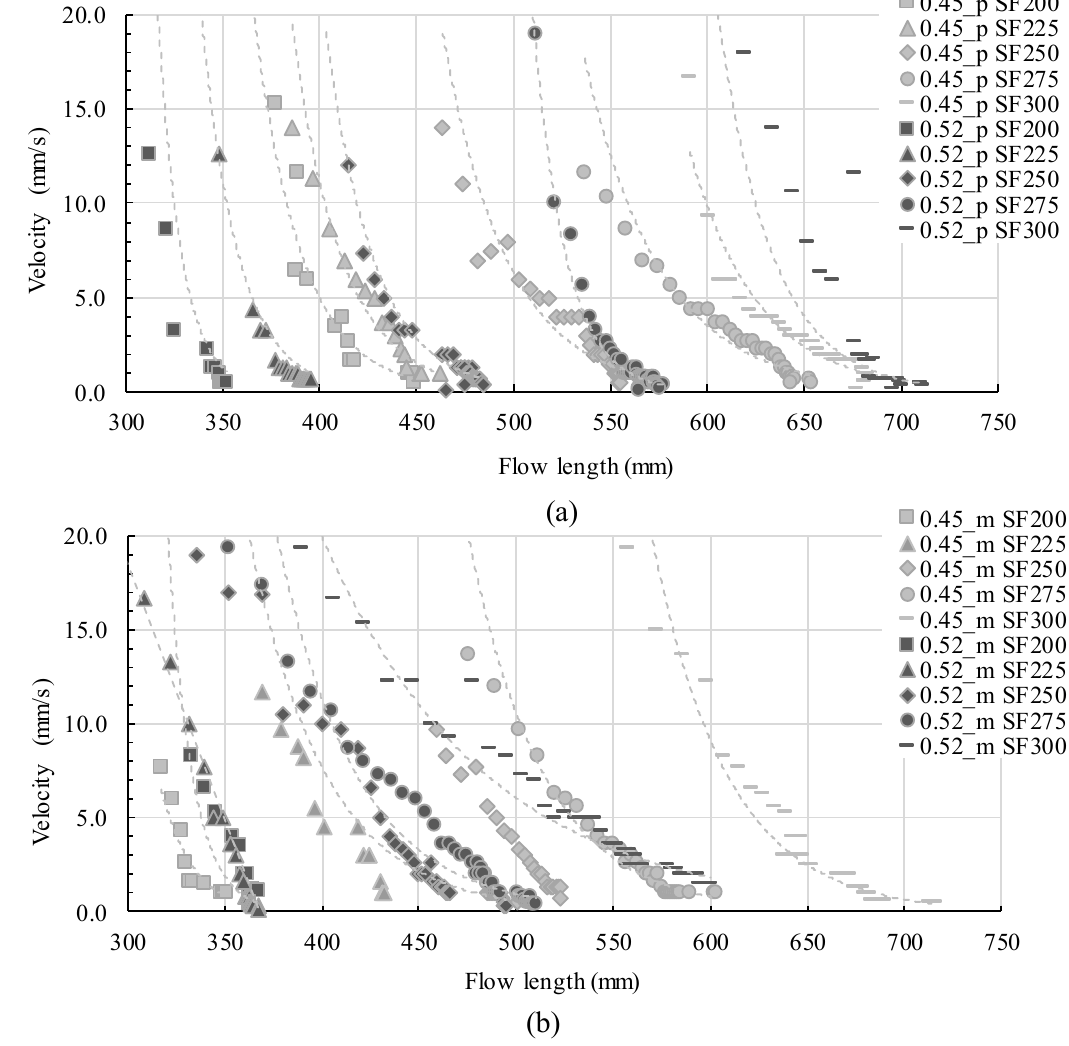
Figure 7. Velocity profiles for ( a ) paste series and ( b ) mortar series.